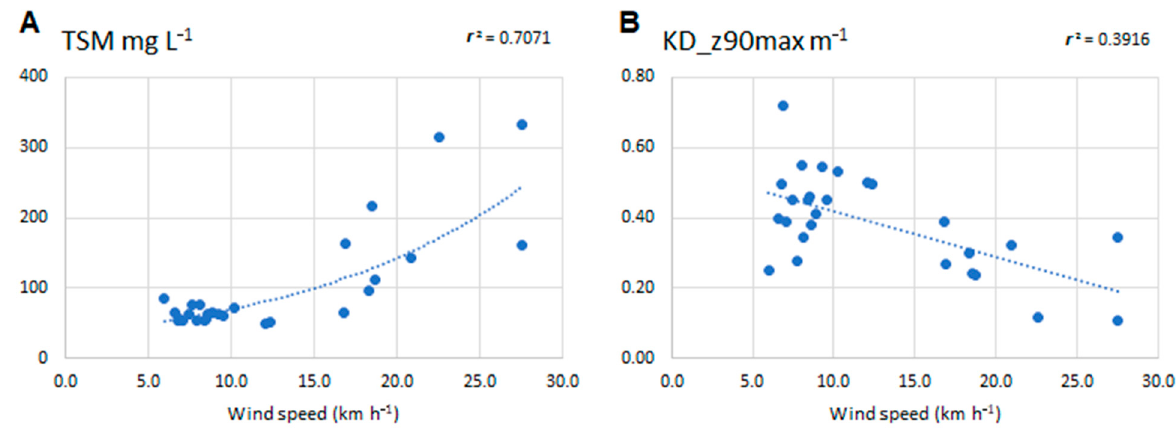
Figure 5. ( A ) Correlations between daily mean wind speed and total suspended matter (TSM) and ( B ) diffuse attenuation coefficient (KD_z90max).